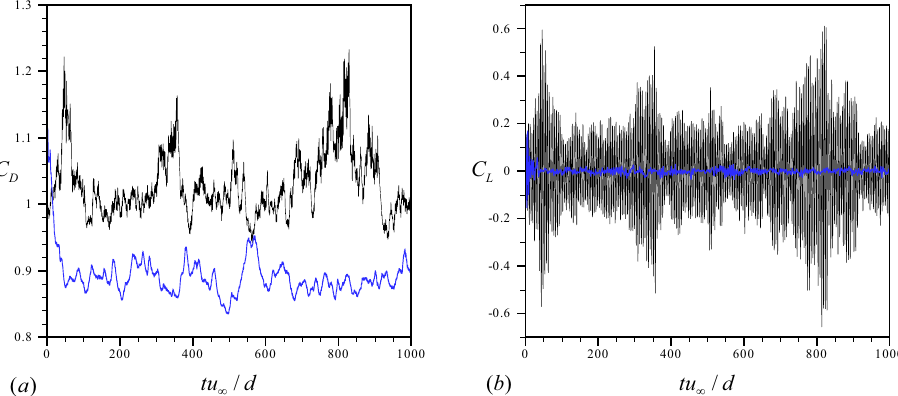
Figure 5. Time histories of drag and lift coefficients with and without tabs: ( a ) drag coefficient; ( b ) lift coefficient. Black line, cylinder without a tab; blue line, cylinder with tabs of l y / d = 0.2 and l z / d =